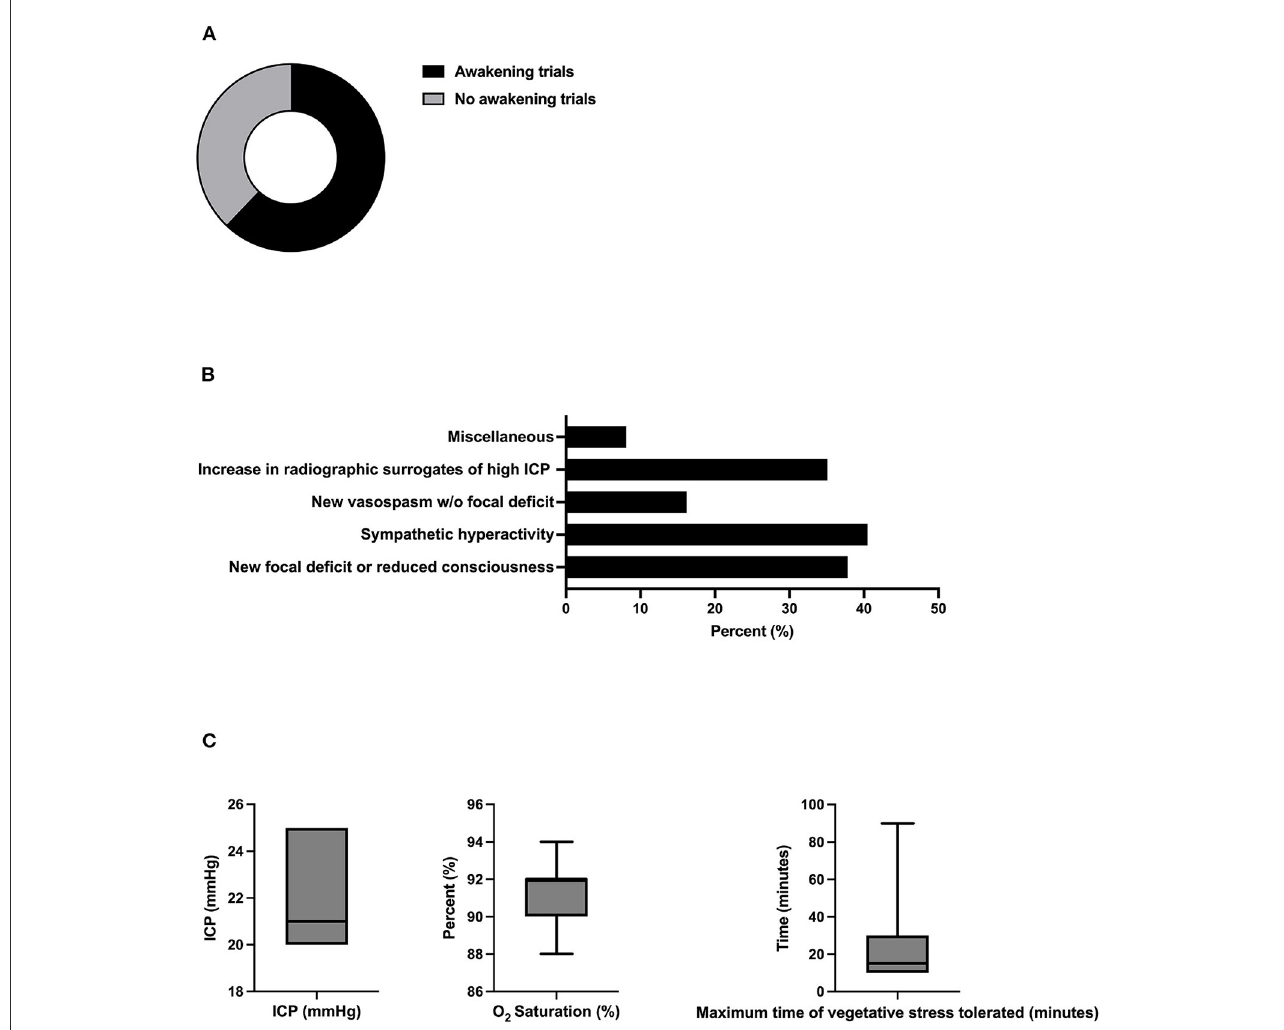
FIGURE2 Relevance and safety criteria of daily awakening trials. (A) Proportion of experts performing daily awakening trials in patients in SAH ( n = 37). (B) The proportion of experts applying pre-defined safety criteria for interruption of sedation. (C) Relevance of predefined safety criteria for interruption of sedation ( n = 17, multiple selections). Miscellaneous included critical reduction in brain tissue oxygen tension (PtbO2, n = 2), status epilepticus ( n = 1), and hypocapnia (pCO2 < 30mmHg, n = 1). (C) Thresholds of ICP, vegetative stress, and oxygen saturation. w/o, without, ICP; intracranial